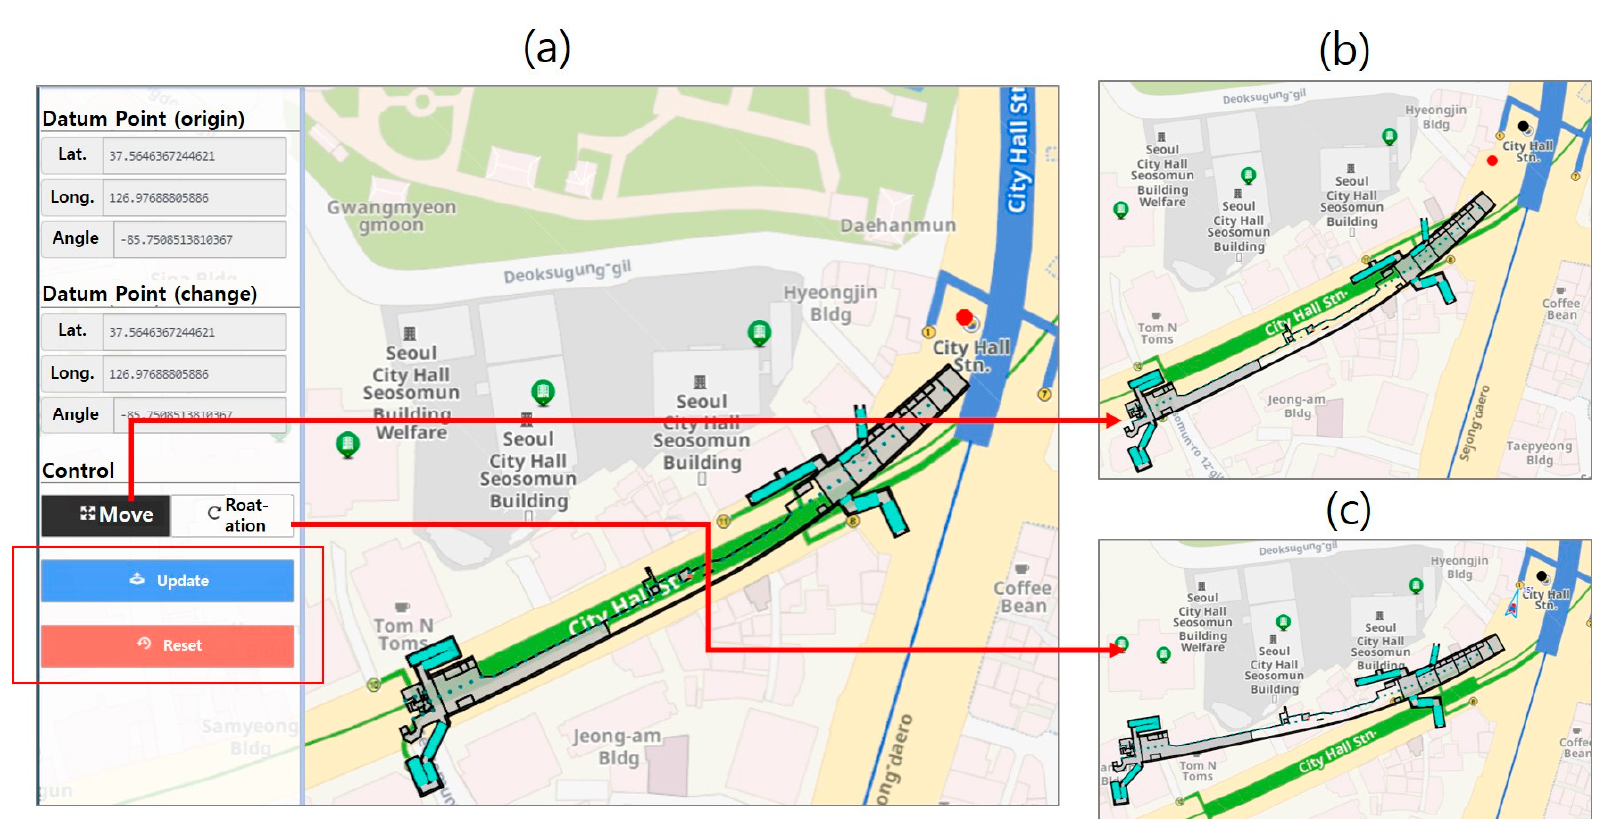
Figure 4. Two-dimensional data translation and rotation function: ( a ) user interface, ( b ) data translation, and ( c ) data rotation.